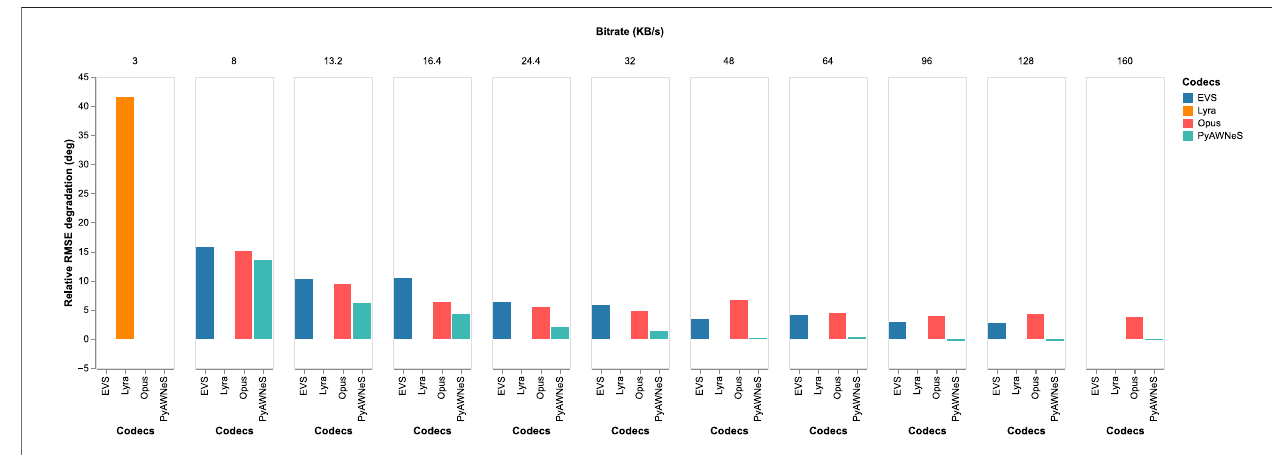
FIGURE 8 | Relative RMSE (deg) versus an increasing bitrate (KB/s) performed by the model trained without compression ( w / o codec ) on a test set including similarly encoded signals.